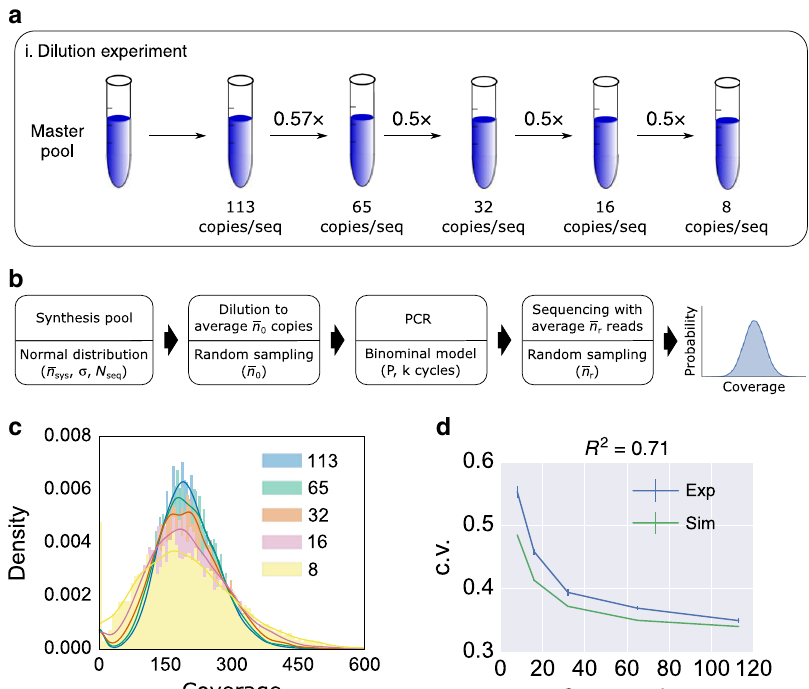
Fig. 5 Dilution-PCR experiment. a The experimental work fl ow. A master DNA pool was diluted to different average copy numbers as indicated in the drawing. Each dilution sample was PCR-ampli fi ed and sequenced using an Illumina NextSeq instrument, and the results sampled at 200x coverage. b A computational model for the dilution-PCR experiments. The synthesis pool model used N seq = 7,373 number of sequences, and normally distributed